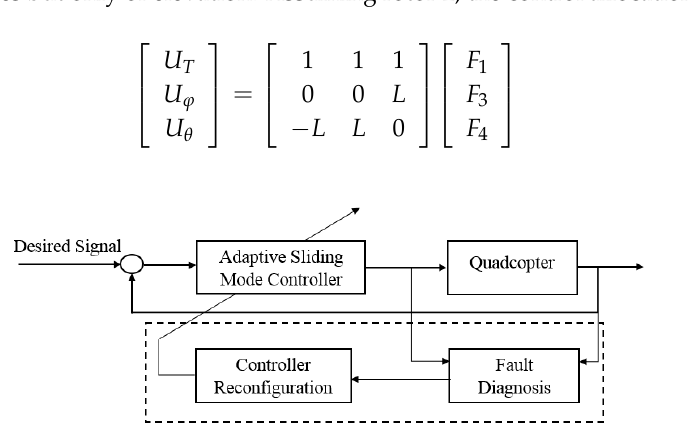
Figure 2. Fault-tolerant control scheme.